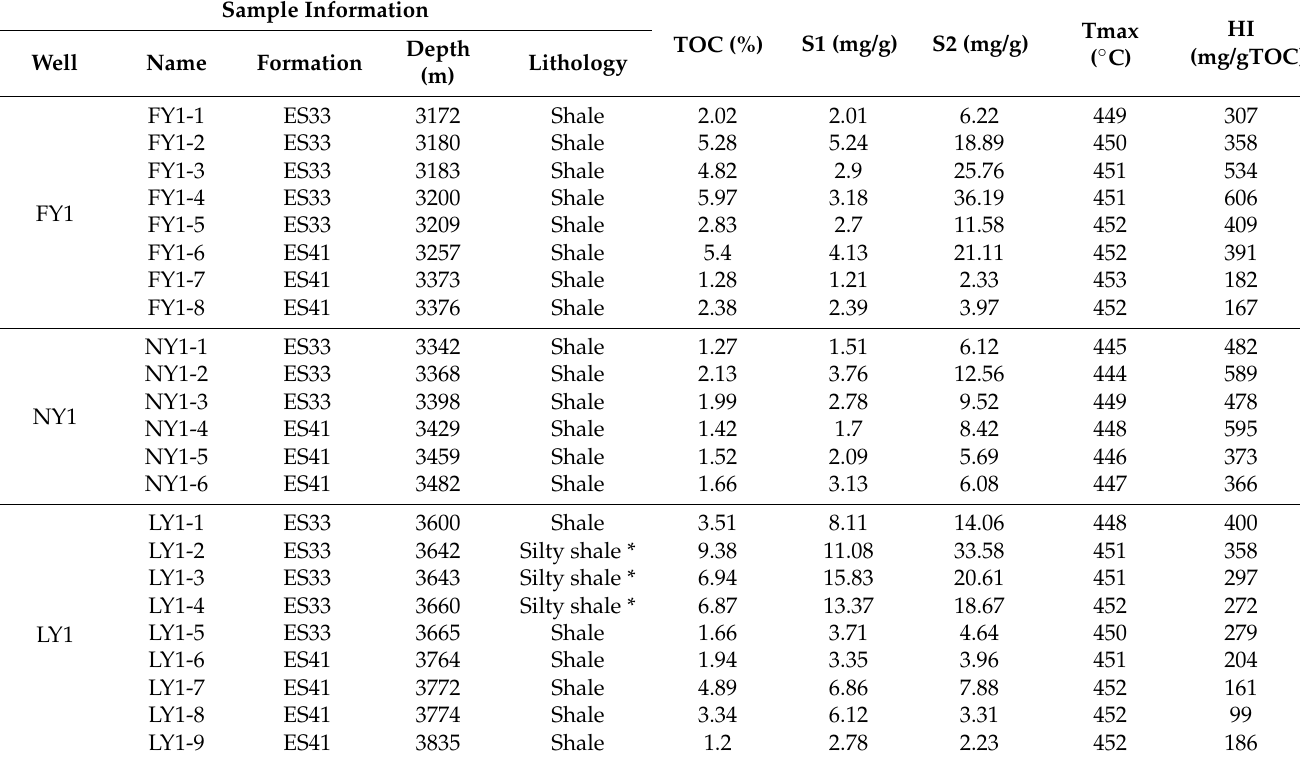
Table 1. Geological and geochemical information of the studied